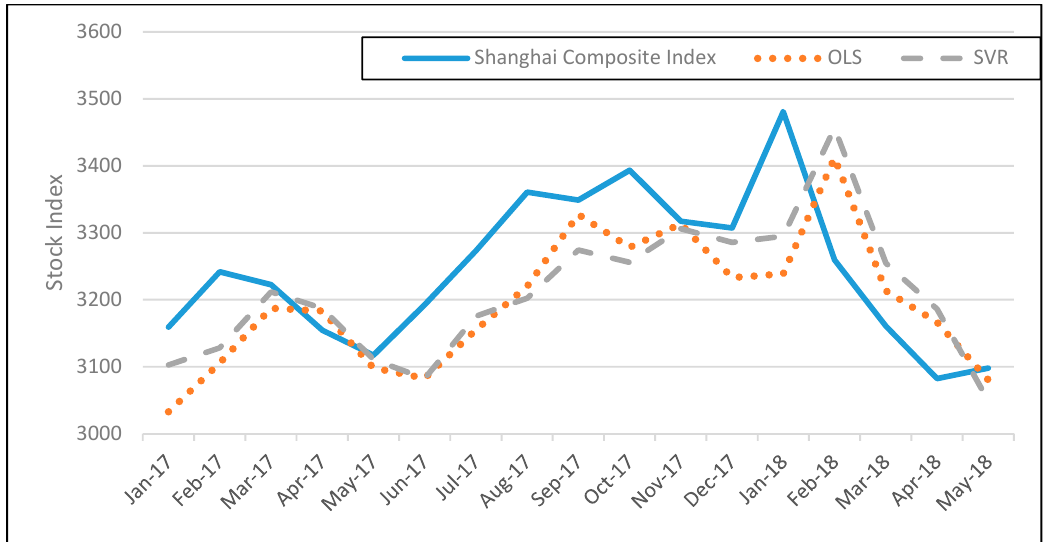
Figure 6. Out-of-sample 1-month ahead exchange rate forecasts for the Shanghai Composite index based on the GPR index for the SVR and OLS model for the period Jan-2017 to May-2018.